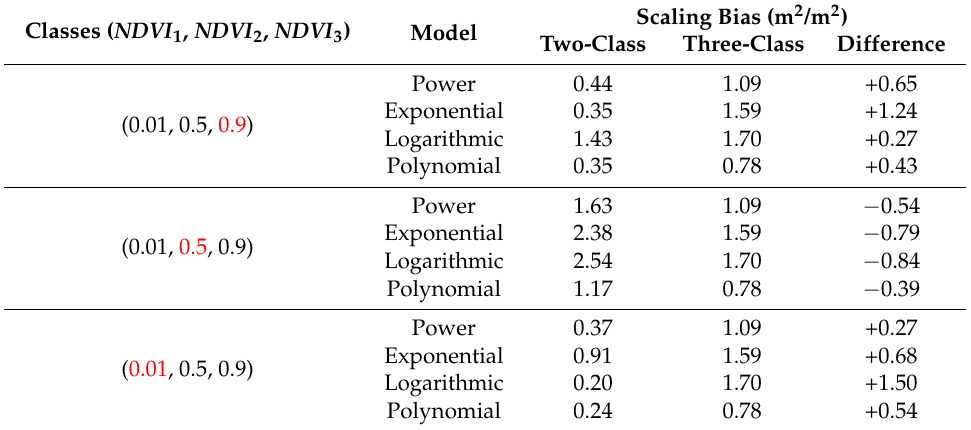
Table 3. Scaling bias values for different types of models and number of classes within a coarse pixel. Classes ( NDVI 1 , NDVI 2 , NDVI 3 )